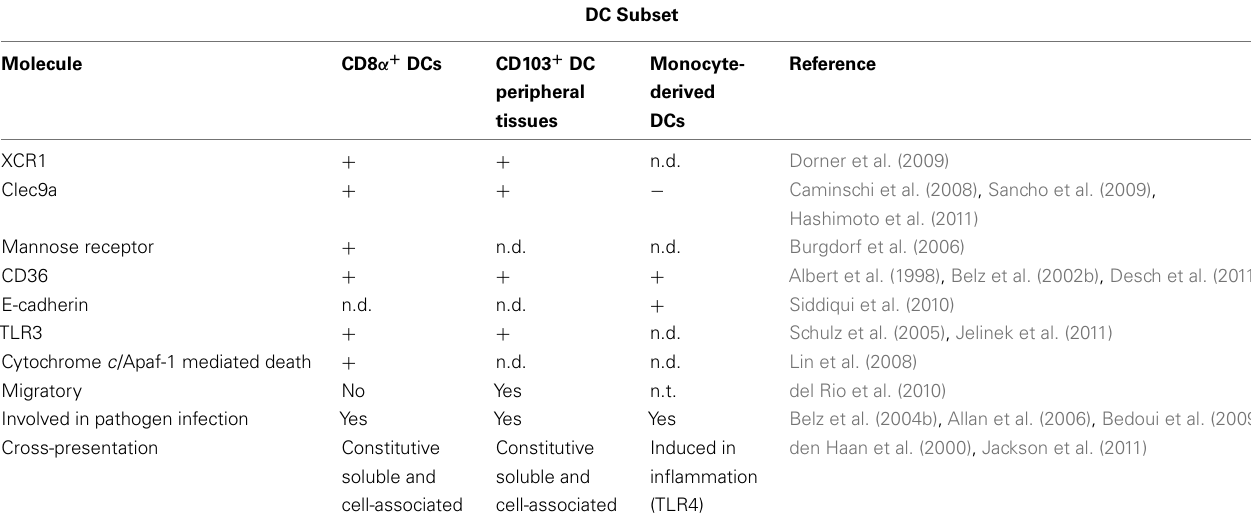
Table 1 | Features of cross-presenting antigen presenting